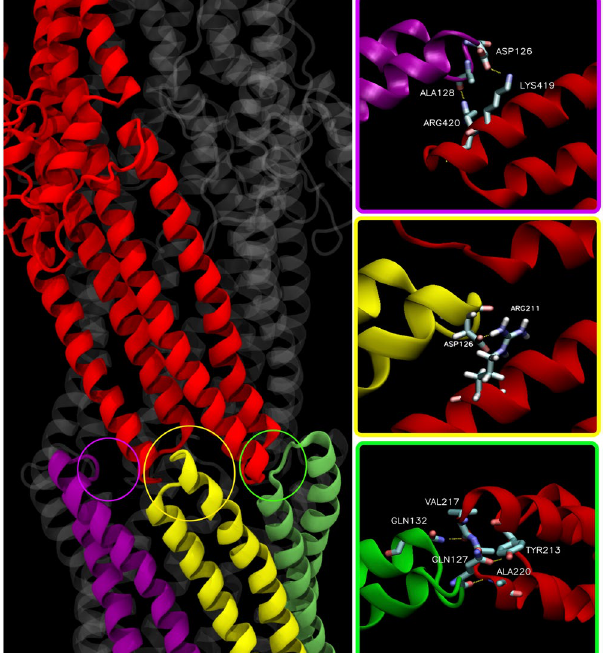
Figure 5. Close-up of the interactions formed during the MexA-dependent opening of the OprM periplasmic aperture. A series of interactions between the α -hairpins of OprM and MexA were formed during the simulation, which are highlighted here for a single OprM protomer (red ribbons). Within these interactions, we present the ones stabilized by specific hydrogen bonds. Thus, two hydrogen bonds are observed with MexA protomer 1 (purple ribbon), one hydrogen bond with MexA protomer 2 (yellow ribbons) and three hydrogen bonds with MexA protomer 3 (green ribbons). Water molecules were removed here for a clearer